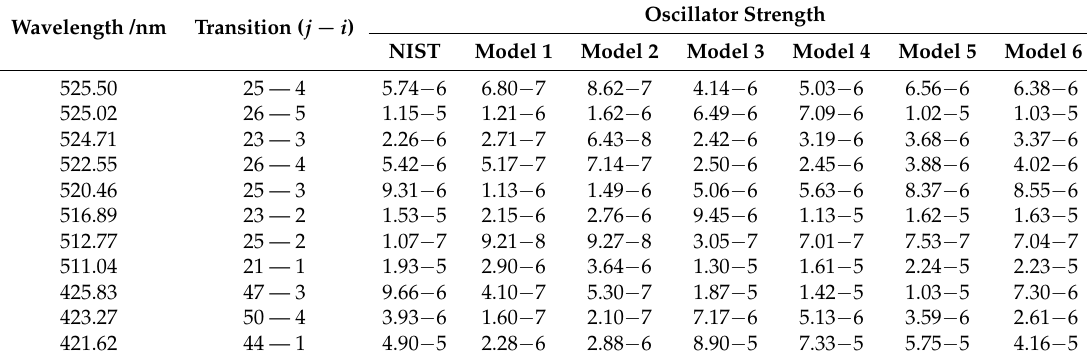
Table 3. E1 oscillator strengths from various models compared with the accurate NIST values, where a − b ≡ a × 10 − b